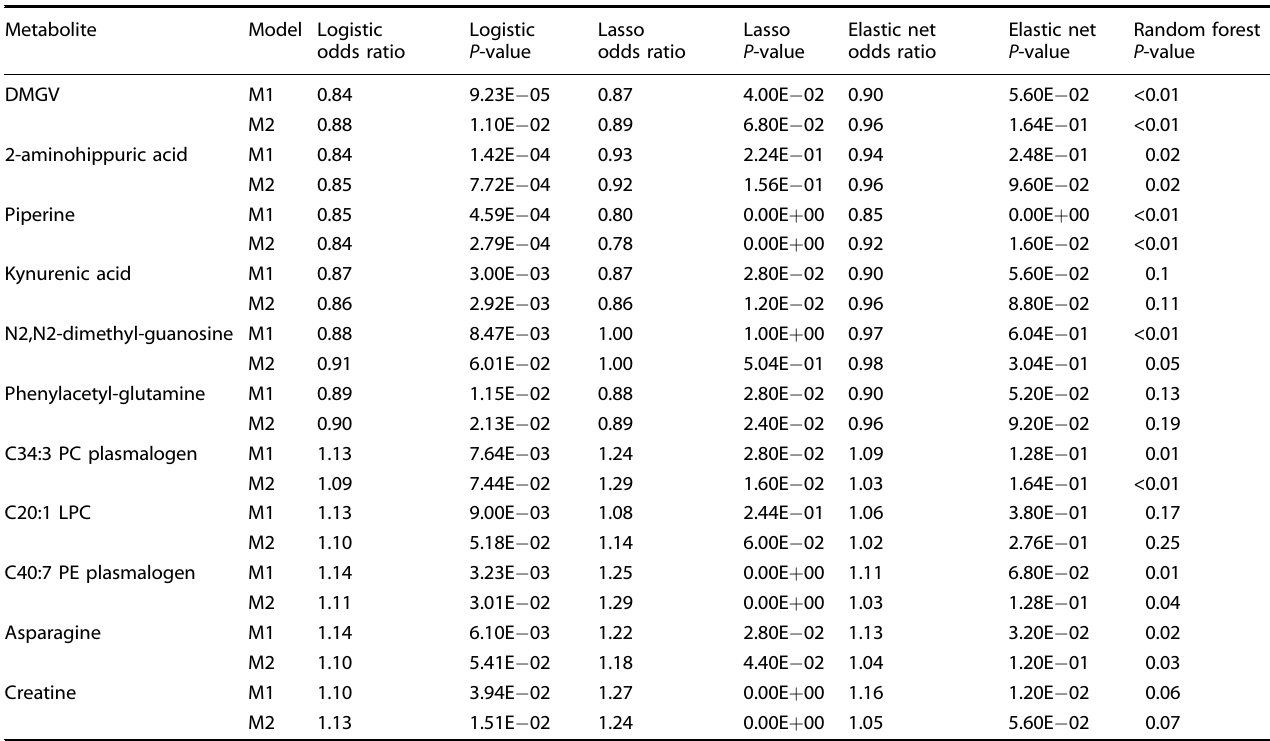
Table 3. All metabolites that met q -value < 0.2 in at least one primary model analysis that adjusts for matching factors. M1 is the simple model a (accounting for matching factors) and M2 is the adjusted model b (adjusting for matching factors and breast cancer risk factors).